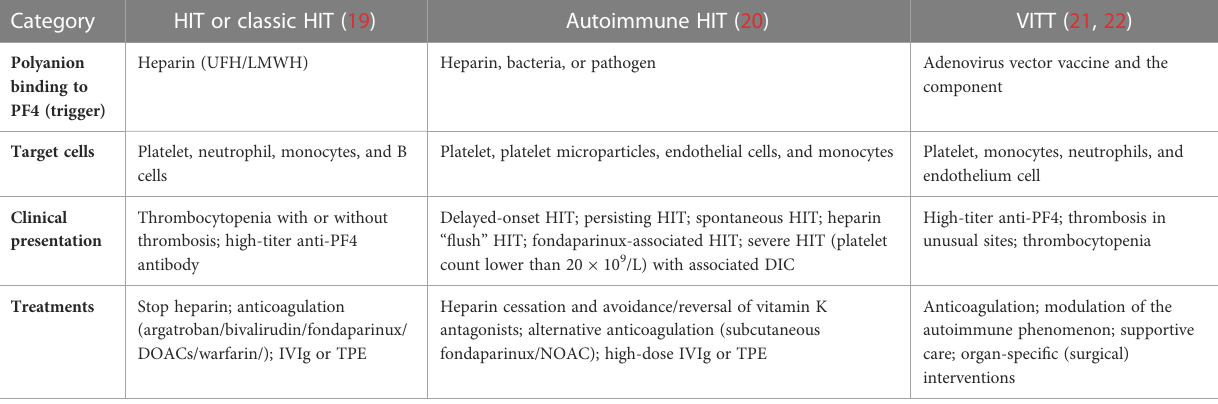
TABLE 1 Potential mechanism of PF4 in different thrombosis diseases.